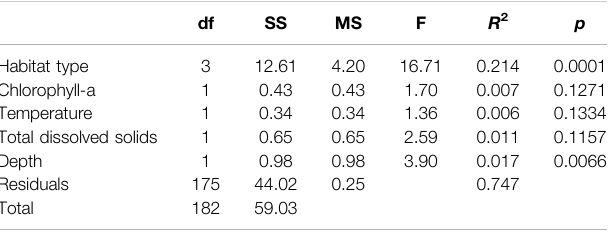
TABLE 7 | ANOVA table for the permutational statistical model of abundance- based species composition.